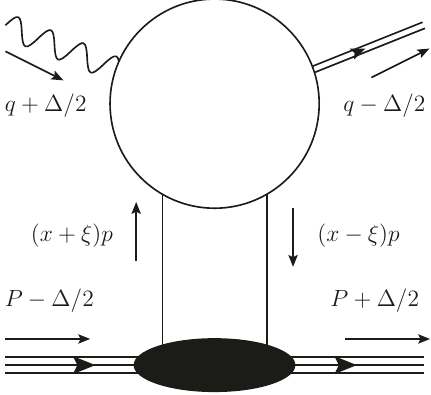
Figure 1 . Schematic representation of HVM